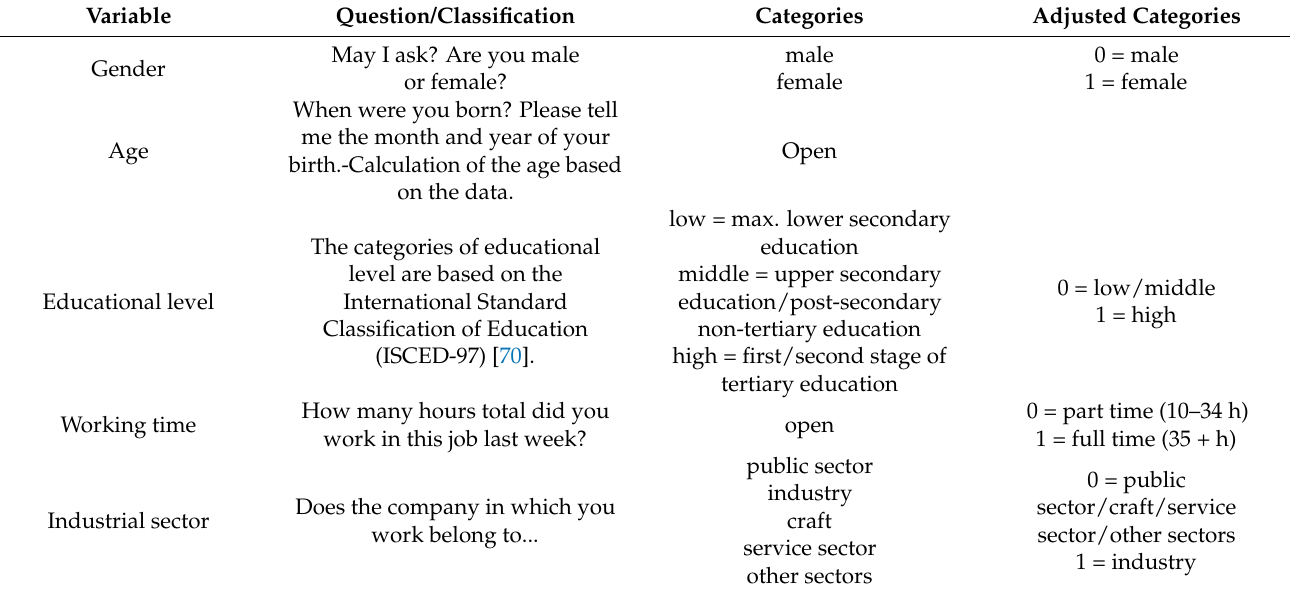
Table A1. Measurement of control